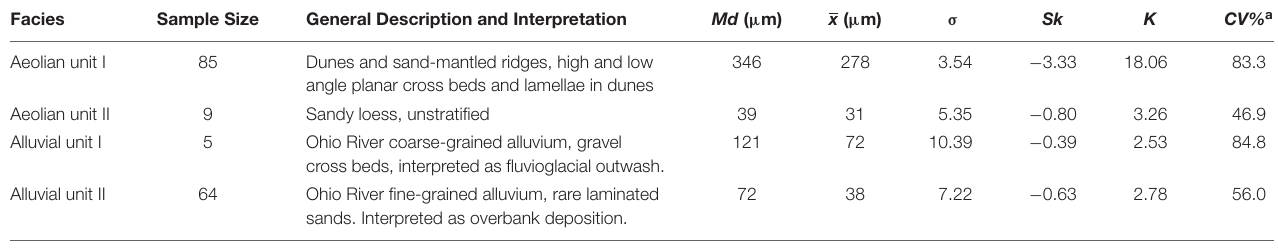
TABLE 2 | Particle-size description and characteristics by facies type ( n = 163 samples).